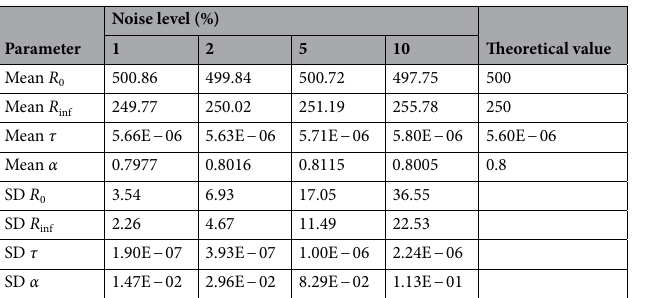
Table 6. Parameters obtained by the 3P method with simulated spectra created with different percentages of added noise. Form 1.